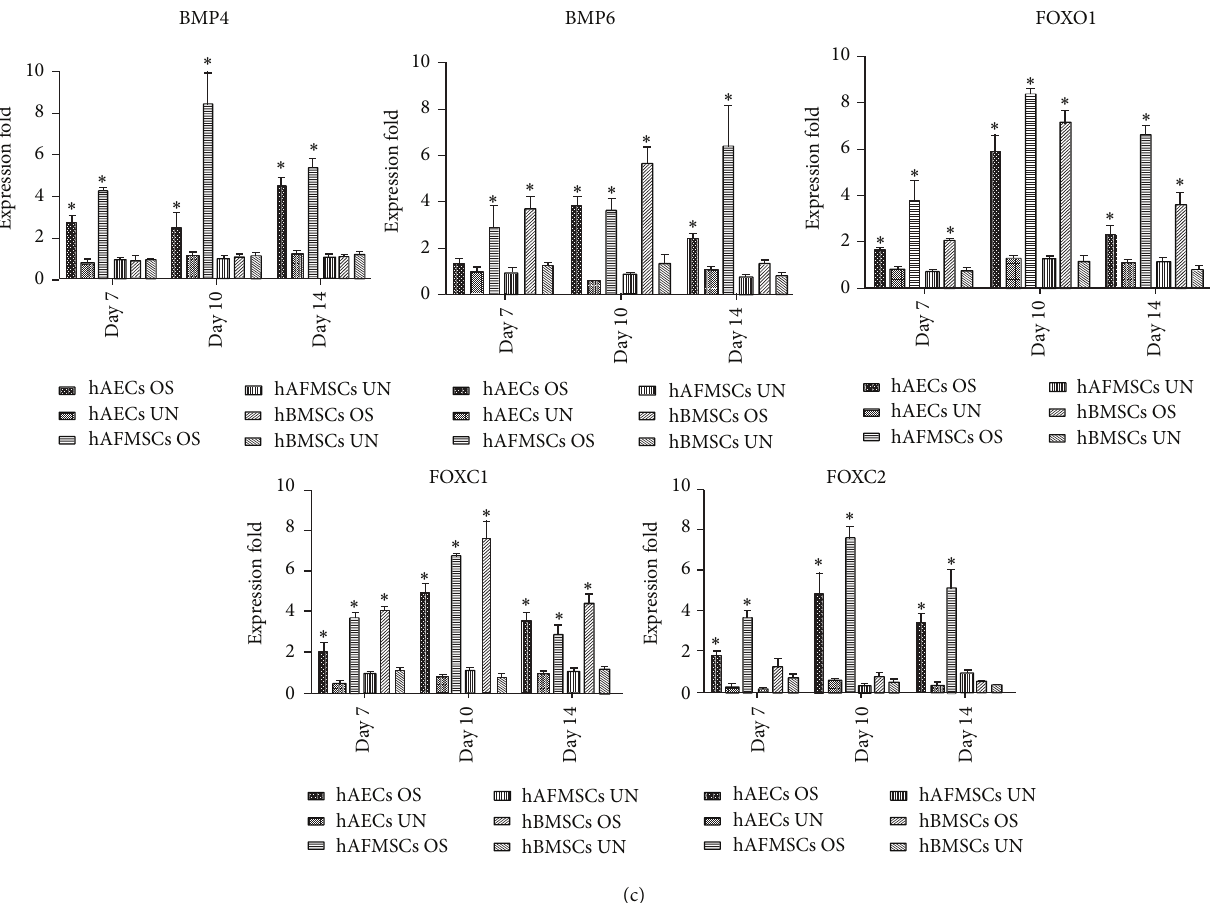
Figure 3: hAECs, hBMSCs, and hAFMSCs show a different molecular response to osteogenic induction in vitro . (a) Hierarchical cluster analysis of the differentially expressed genes involved in ossification. (b) Protein-protein interaction network analysis of the genes upregulated in hAECs, hBMSCs, and hAFMSCs after the 7-day osteogenic induction. (c) RUNX2, OSX, COLI, ALP, OPN, BMP6, FOXO1, and FOXC1 in osteogenic groups were gradually upregulated with time compared to those in the control group, while BMP4 and FOXC2 were only significantly upregulated in hAECs and hAFMSCs but not hBMSCs ( ∗ : 𝑃 < 0.05 ).